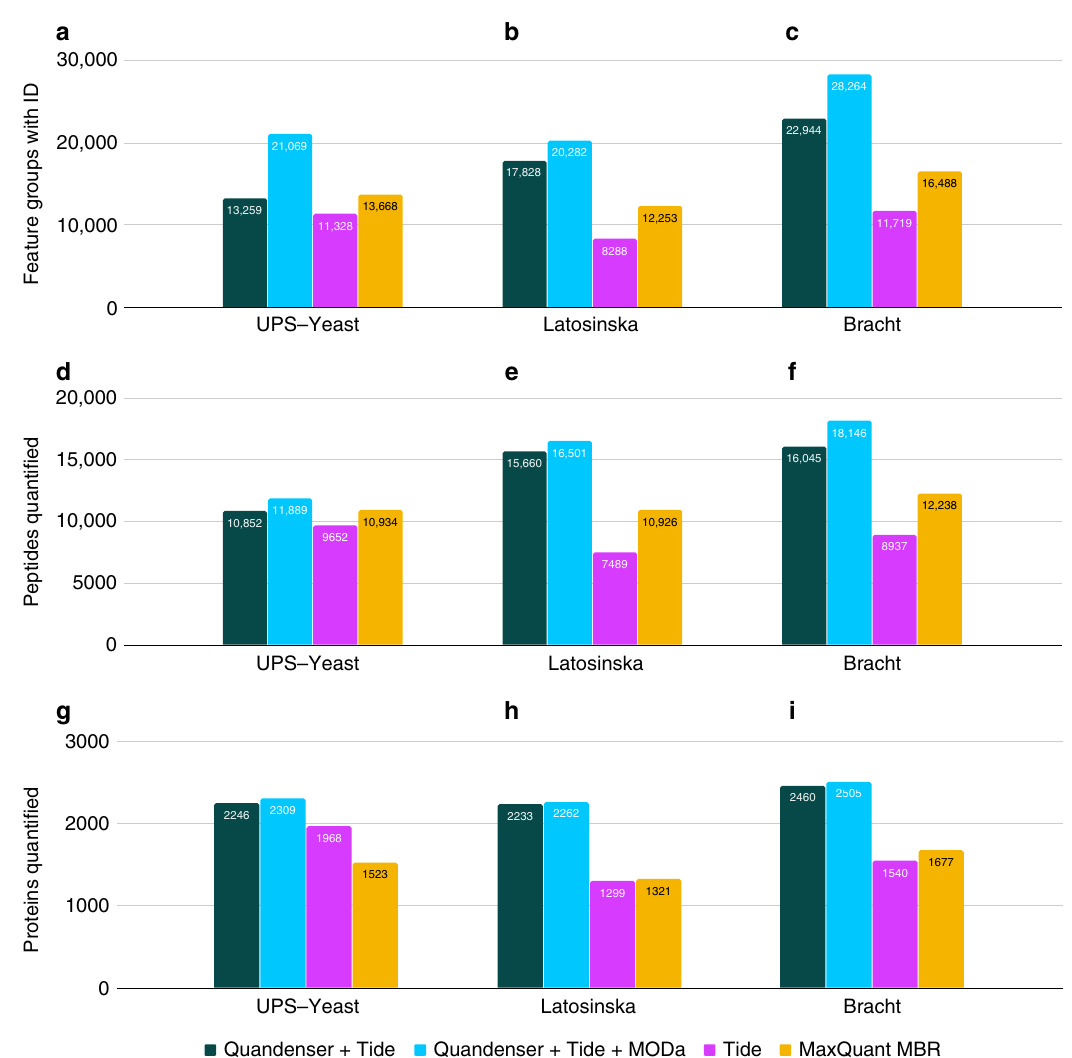
Fig. 1 Number of identi fi cations. Using Quandenser, with and without the open modi fi cation search, increases the number of quanti fi ed peptides and proteins compared with not clustering and MaxQuant MBR. Performing an open modi fi cation search after a normal database search drastically increases the number of feature groups with identi fi cations. We plot the number of feature groups with identi fi cation ( a – c ), quanti fi ed peptides ( d – f ), and quanti fi ed proteins ( g – i ) at 1% identi fi cation FDR after applying the maximum missing value criterion. The analyzed methods were Quandenser + Tide (green), a cascade search of fi rst Tide and subsequently MODa (light blue), Tide without Quandenser (magenta), and MaxQuant with MBR (yellow). For the comparison on protein level one should bear in mind that MaxQuant requires at least two unique peptides for protein identi fi